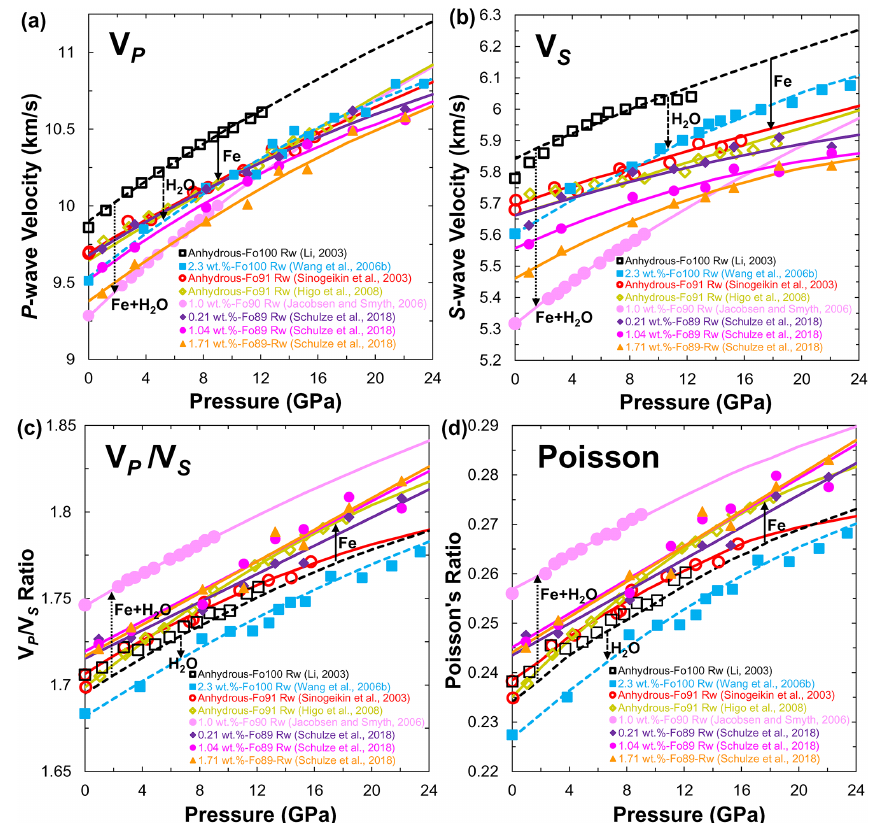
Figure 12. (a) Compressional ( V P ), (b) shear wave ( V S ) velocities, (c) V P /V S ratio and (d) Poisson’s ratio of ringwoodite at 300K as a function of pressure. Data sources: anhydrous ringwoodite (single crystal: Sinogeikin et al., 2003; polycrystal: Li, 2003; Higo et al., 2008); hydrous ringwoodite single crystal (Jacobsen and Smyth, 2006; J. Wang et al., 2006; Schulze et al., 2018). Closed and open symbols denote the experimental data, and solid and dashed lines stand for the calculated results from third-order finite strain